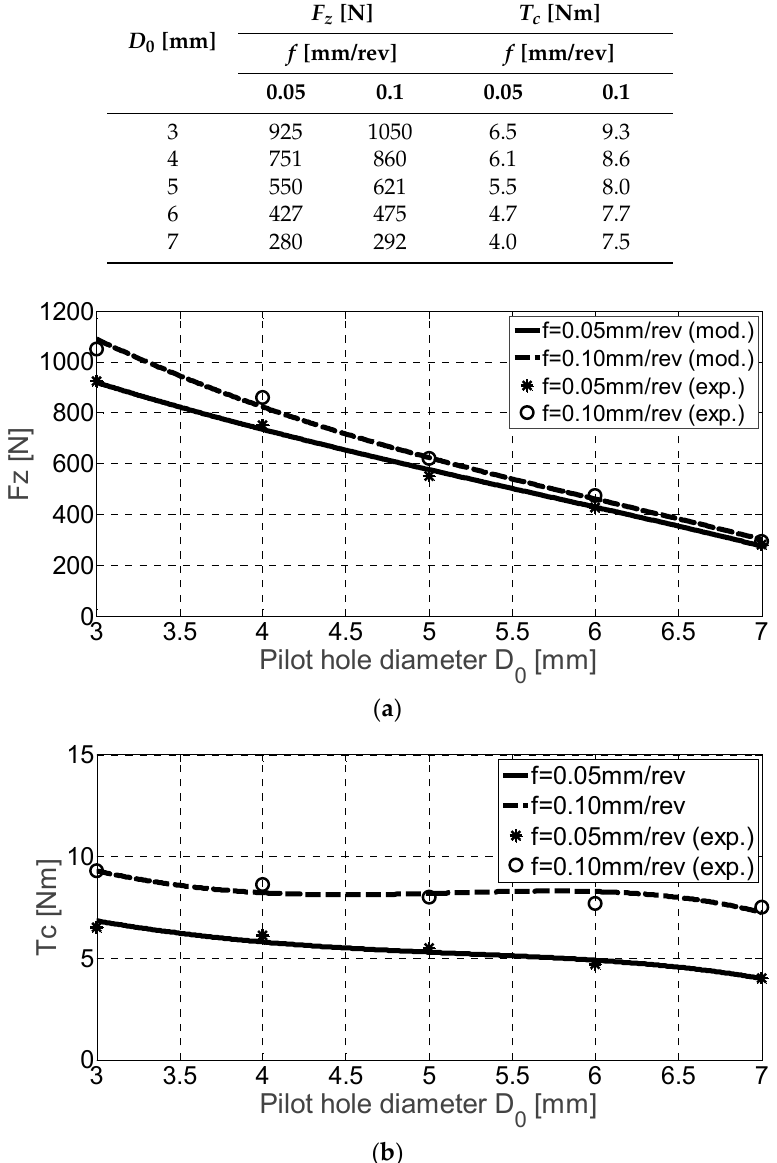
Table 7. Experimental results for F z [N] and T c [Nm] in extruded MoCuSi alloy.